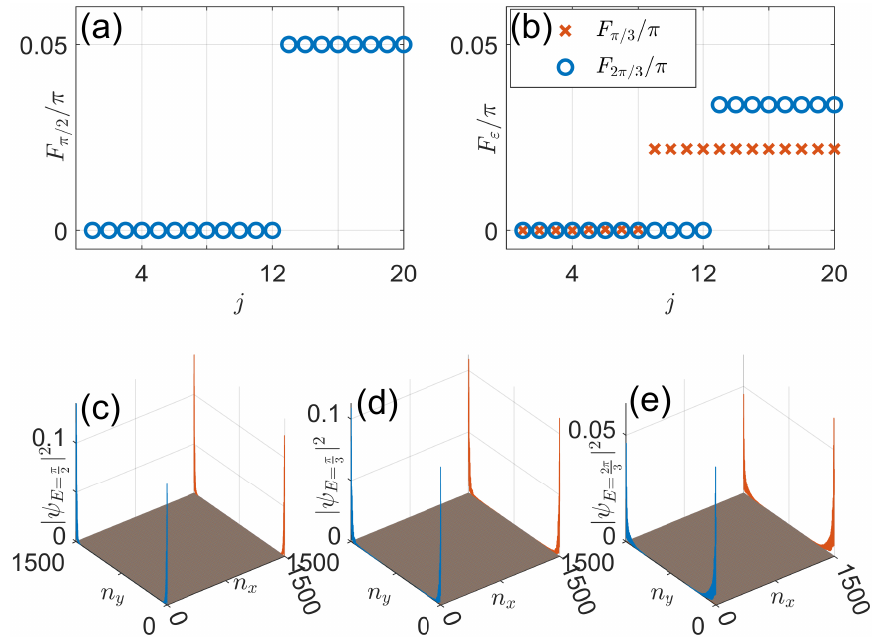
Figure 11: Gap functions and probability distributions of corner modes for U (a), (c) and for U in (b), (d), (e). The notations, system parameters and size of 1 / 3 lattice are the same as those used in Fig. 7. (c) shows four out of the twelve π/ 2 corner modes. (d) shows four out of the eight π/ 3 corner modes. (e) shows four out of the twelve 2 π/ 3 corner